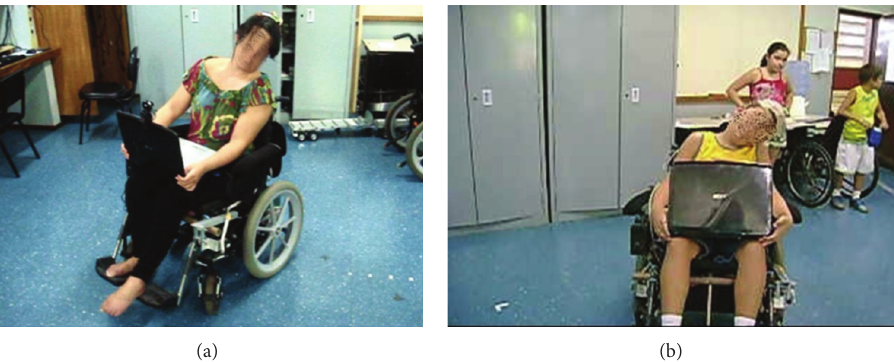
Figure 7: Volunteers with motor disabilities while using the proposed assistive system.